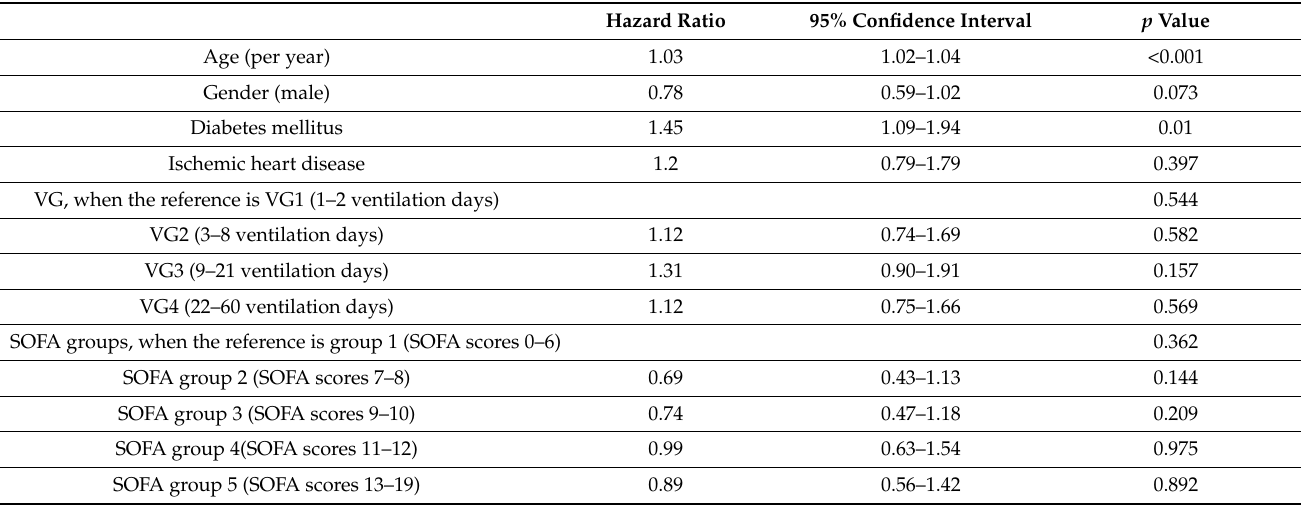
Table 4. Cox regression multivariable model results for factors associated with post-hospitalization survival. Hazard Ratio 95% Confidence Interval p